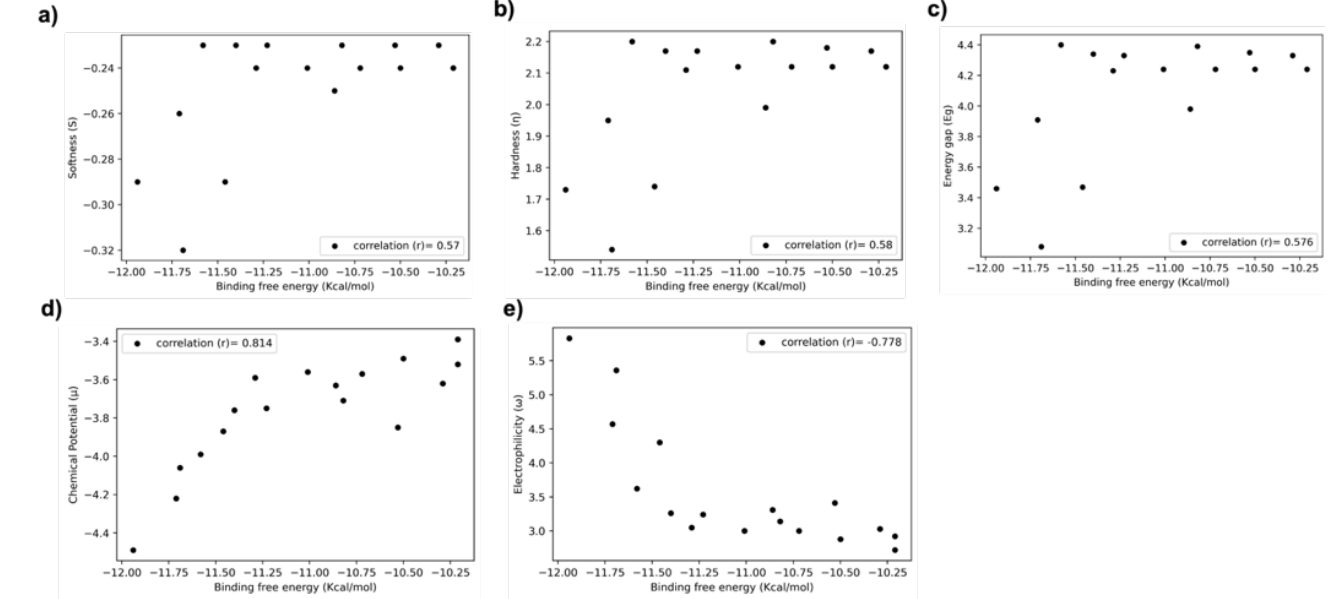
Figure 8. The relationship between DFT properties/descriptors and reference, halogen-substituted compounds. The Pearson correlation between binding free energy and softness, hardness, energy gap, chemical potential, and electrophilicity (( a – e ), respectively).